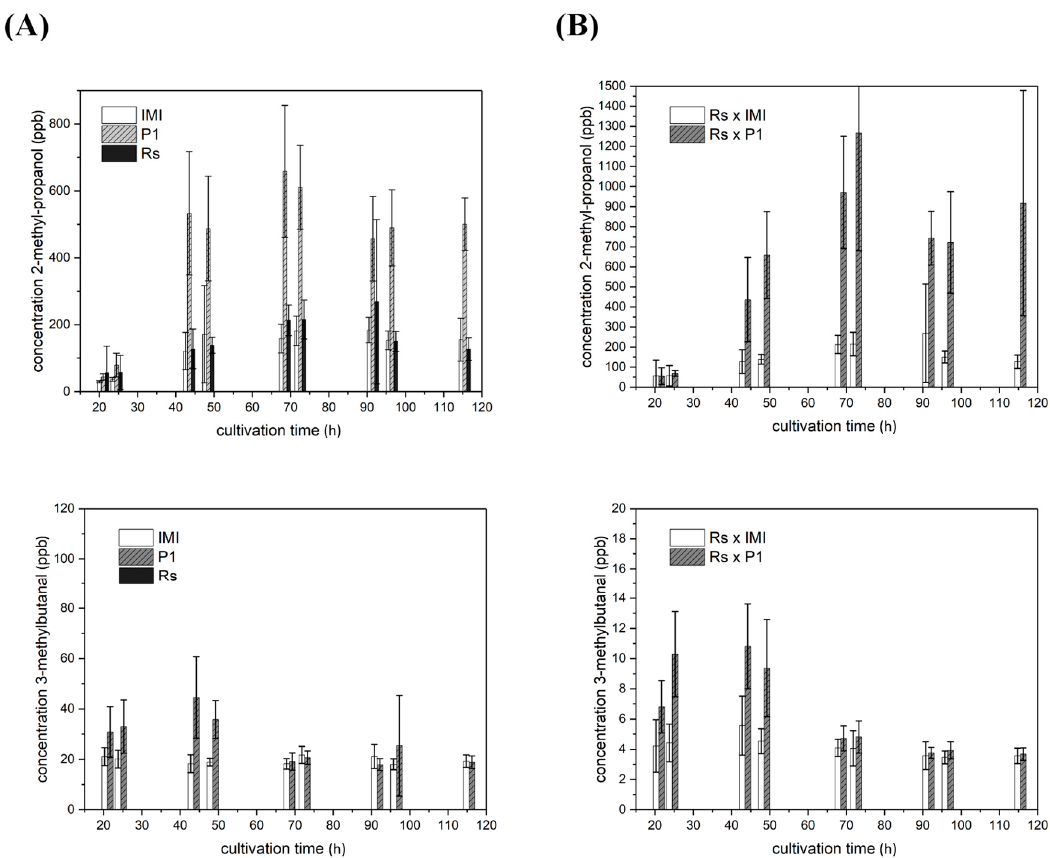
Figure 6. Emission levels of light-independently produced VOCs upon co-cultivation of T. atroviride P1 or IMI 206040 with R. solani . Levels (ppb) of 2-methyl-propanol (row 1) and 3-methylbutanal (row 2 ) detected in the headspace of ( A ) axenic cultures of T. atroviride P1 (P1), T. atroviride IMI 206040 (IMI) and R. solani (Rs) or of ( B ) co-cultures of T. atroviride P1 or IMI 206040 confronted with R. solani (Rs × P1; Rs × IMI) upon cultivation on PDA in Schott bottles at 25 ◦ C. GC–IMS measurements were conducted along a cultivation period of 120 h. As the given volatiles were produced in similar amounts under light-dark conditions and in complete darkness, results shown are means ± SD ( n =